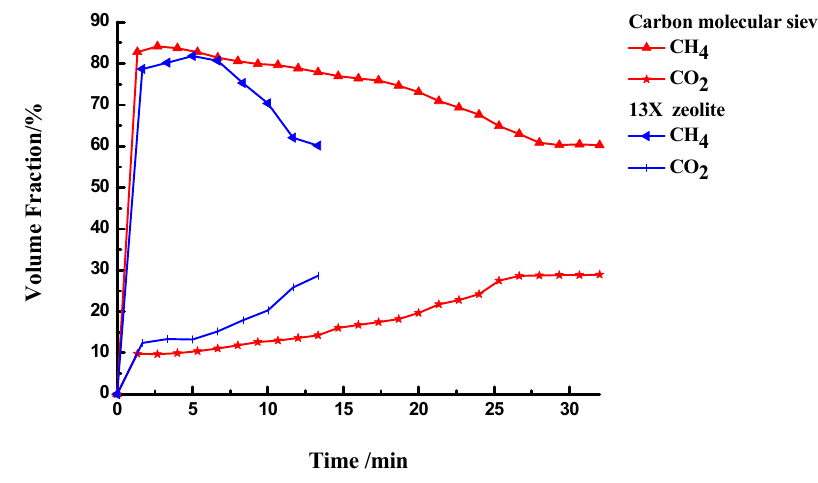
Figure 5. Breakthrough curve of CH 4 and CO 2 in wet desulfurized biogas at 25 °C and 0.2 MPa .